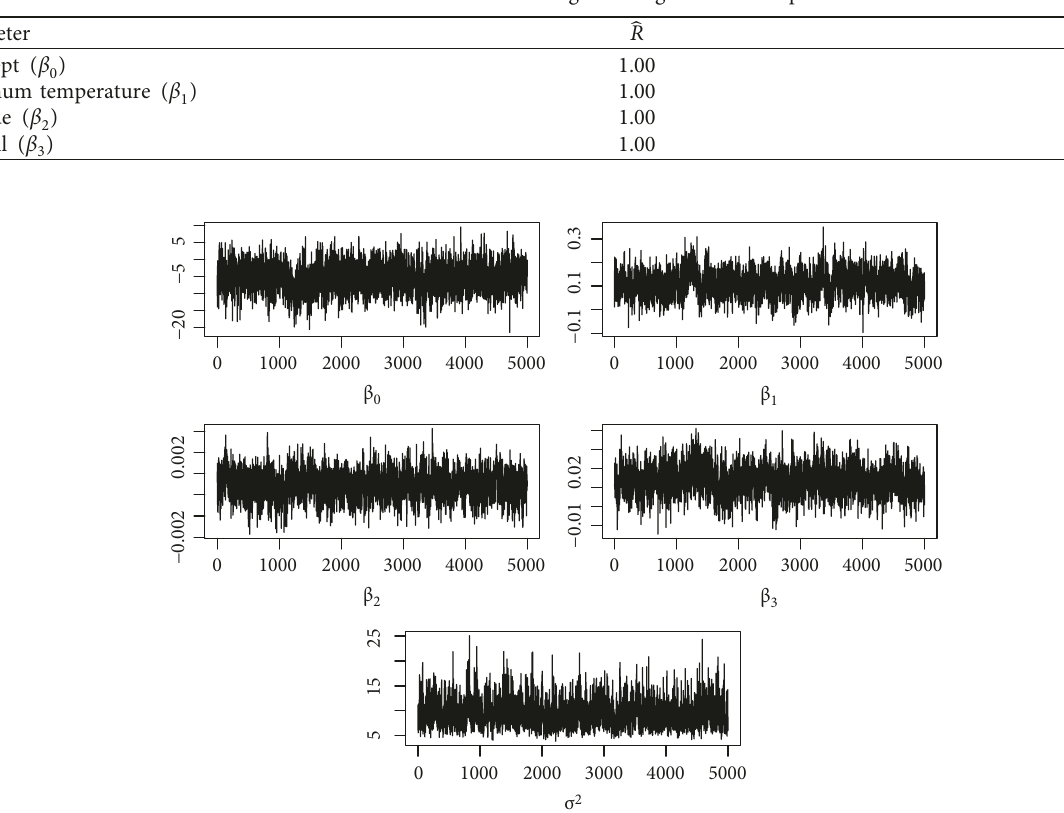
Figure 5: The local spatial autocorrelation indicators (LISAs). (a) Clusters of risk. (b) p value. Table 2: Gelman and Rubin’s convergence diagnostic to the parameter.